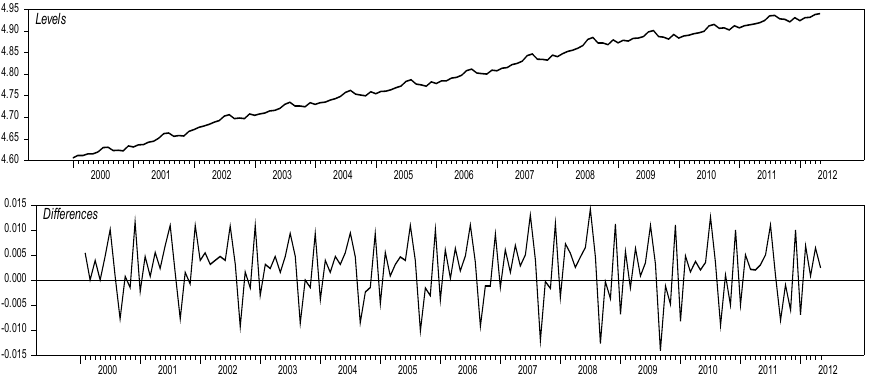
Figure 5. Logarithmic Eurozone price index in the hospitality industry. Data vector January 2000 to May 2012 (Great Depression).